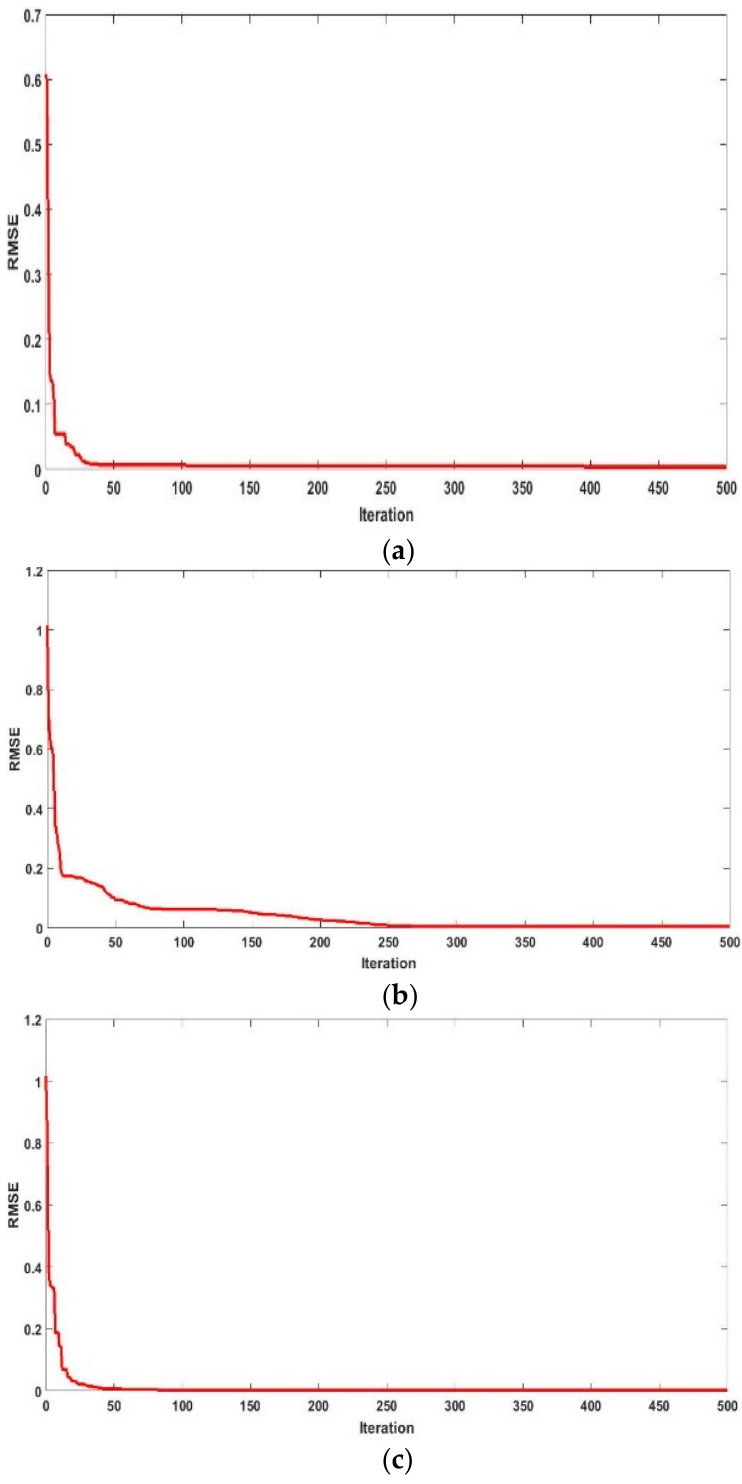
Figure 10. Convergence rates at different environmental impacts using EHO for MTDM; ( a ) at 109.2 W/m 2 and 310.32 K, ( b ) at 246.65 W/m 2 and 313.32 K, and ( c ) at 347.8 W/m 2 and 316.95 K.